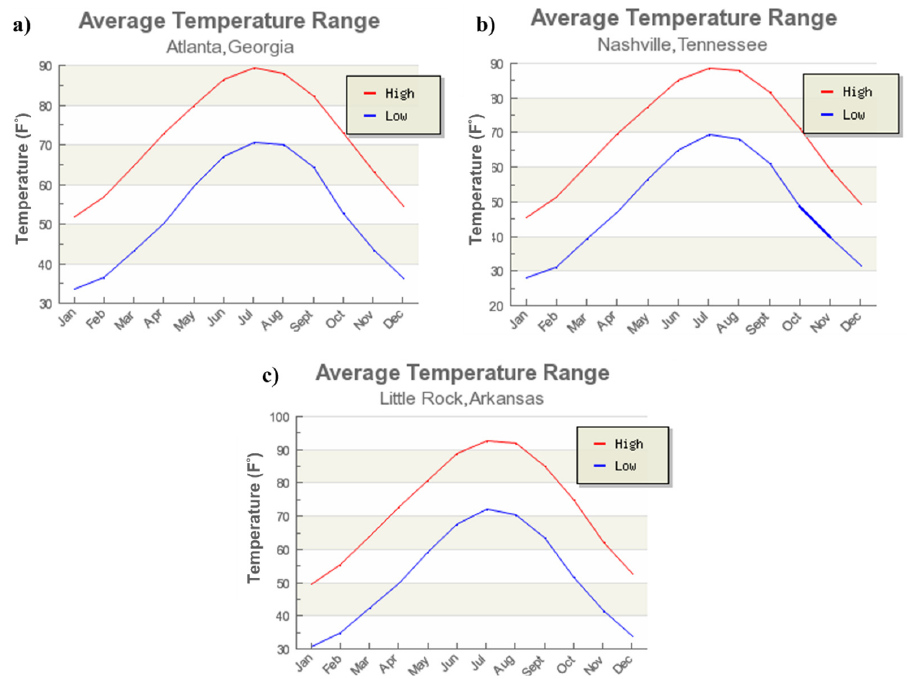
Figure 4. Average temperature changes: ( a ) Changes in section 13 ‐ 3016; ( b ) Changes in section 47 ‐ 0601; ( c ) Changes in section 05 ‐ 0219.